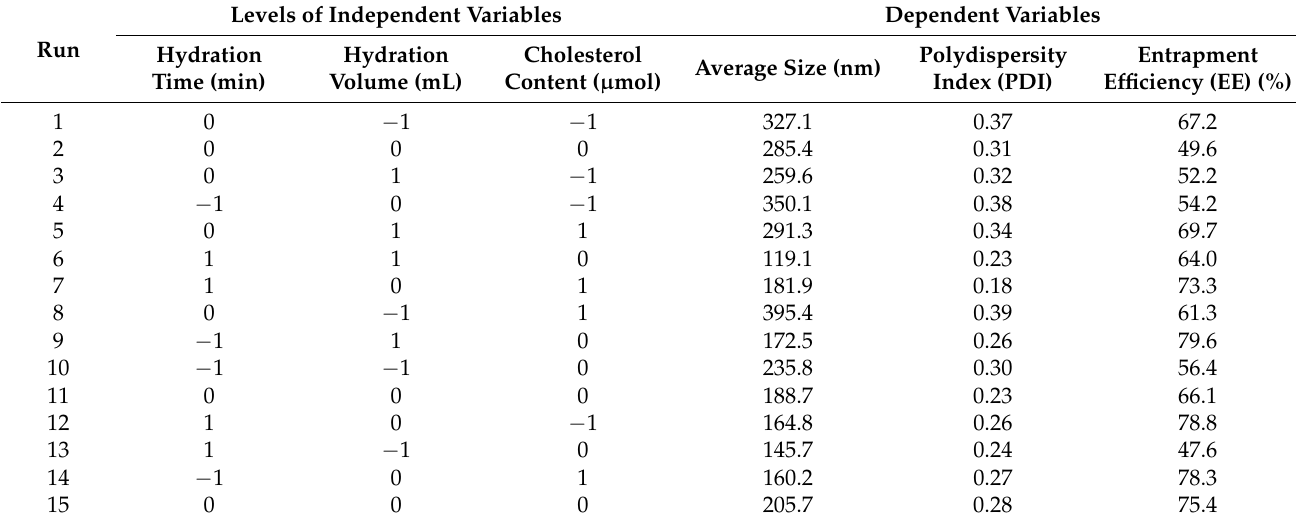
Table 2. Design of Experiments using the Box-Behnken method to optimize the niosomal formulation of E. angustifolia extract. Total lipid (Span 60, Tween 60, and Cholesterol) concentration: 300 µ mol; ratio of Span 60 and Tween 60 set to 1 to 1 (molar ratio); ratio of surfactant and Cholesterol set to 1 to 1 (molar